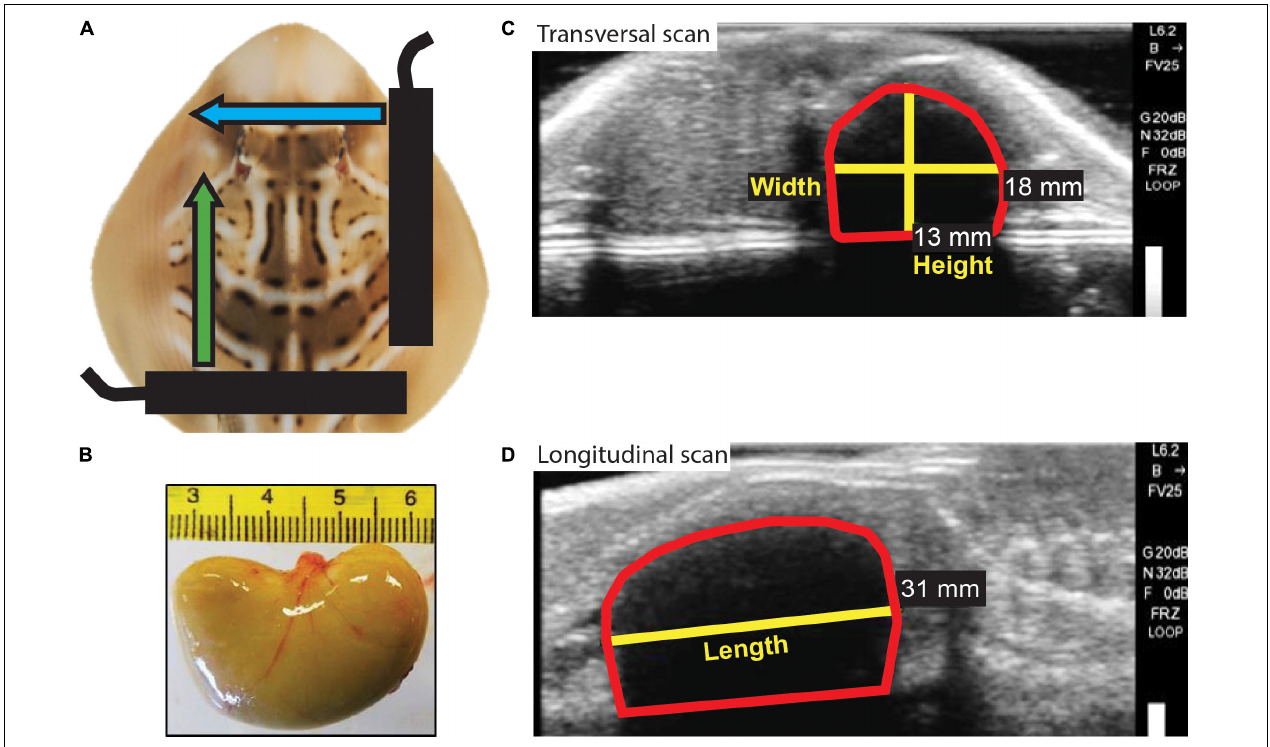
FIGURE 2 | Neonate yolk sac measurements. (A) Schematic representation of ultrasound scans performed on neonates to obtain a longitudinal view and a transversal view of the yolk sac. Black bars represent the ultrasound probe; blue and green arrows represent the movement of the probe during the longitudinal and transversal scans, respectively. (B) Photo of the bean-shaped yolk sac excised from a stillborn neonate. (C) Still image obtained from the transversal scan and used to measure yolk sac height and width. (D) Still image obtained from the longitudinal scan and used to measure yolk sac length. The red shape in (C) and (D) delineates the yolk